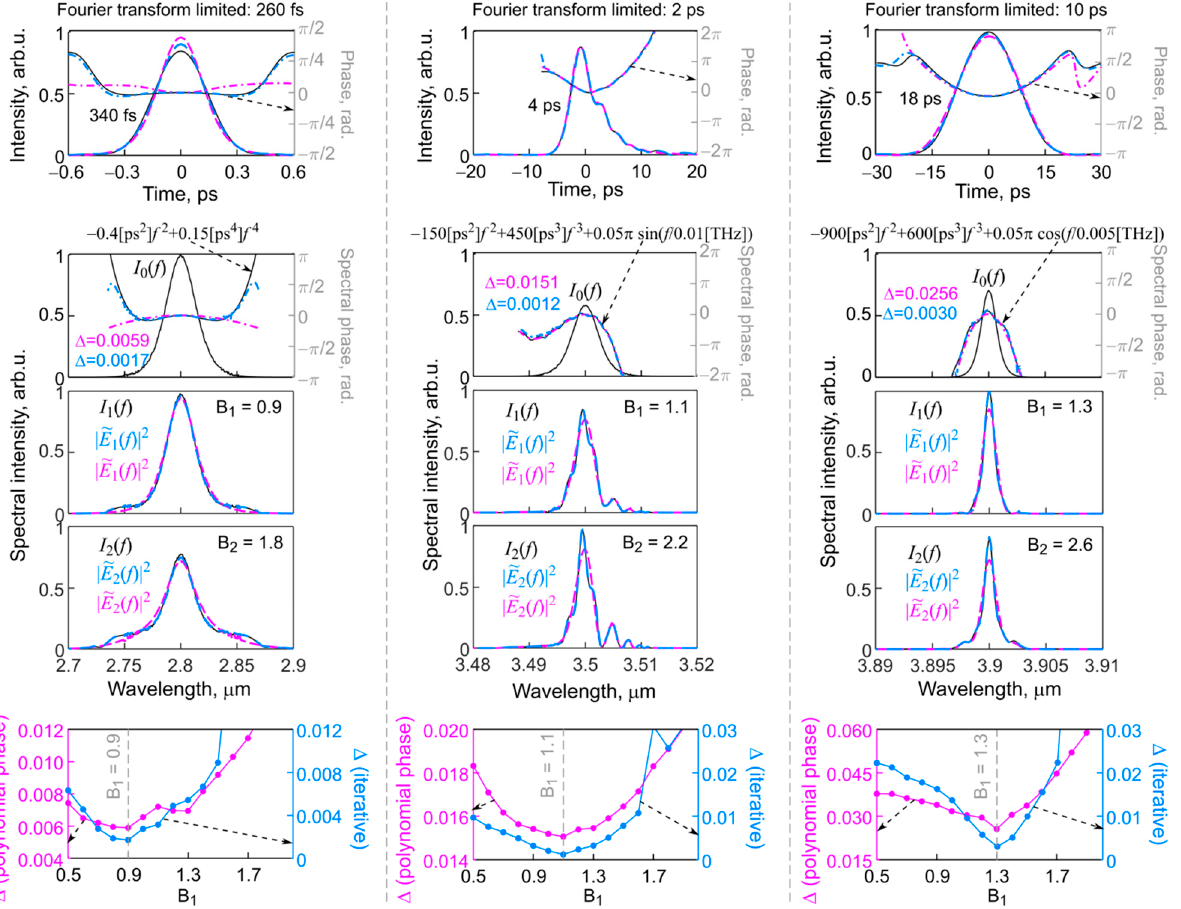
Figure 7. Reconstruction of mid-IR 3 μ m class laser pulses with realistic parameters for commercially available arsenic sulfide glass fibers as nonlinear elements for spectrum conversion. Each column corresponds to an individual pulse. The upper row shows intensity profiles and phases; the second row shows the initial spectra and spectral phases; the third and fourth rows show converted spectra for different B -integrals. Solid black curves correspond to original signals, magenta curves correspond to pulses obtained by the proposed algorithm for polynomial spectral phase searching (dashed—temporal or spectral intensities, dash-dotted—temporal or spectral phases), and blue curves are obtained by the iterative algorithm near the global minimum of error Δ (dashed—temporal or spectral intensities, dash-dotted—temporal or spectral phases). Bottom row shows error functions calculated for different B 1 values (the minima correspond to the original B 1 values). Magenta graphs (left axes) are for algorithm optimizing polynomial phase and blue graphs (right axes) are for iterative algorithm.